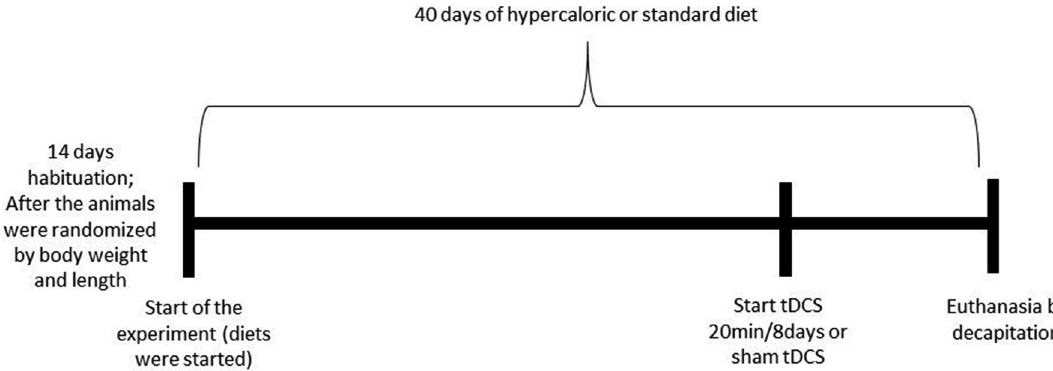
Figure 1. Experimental design. tDCS transcranial direct current